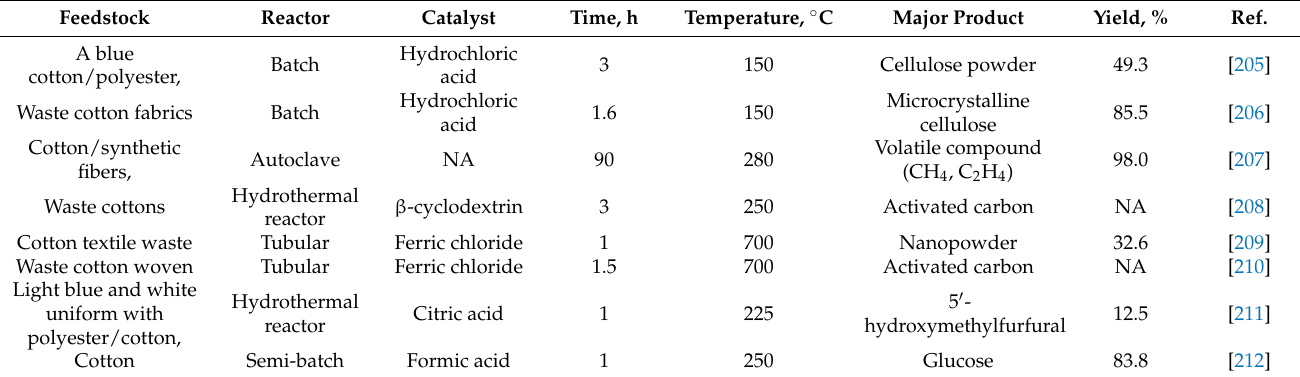
Table 7. Products and conditions of textile recycling using hydrothermal